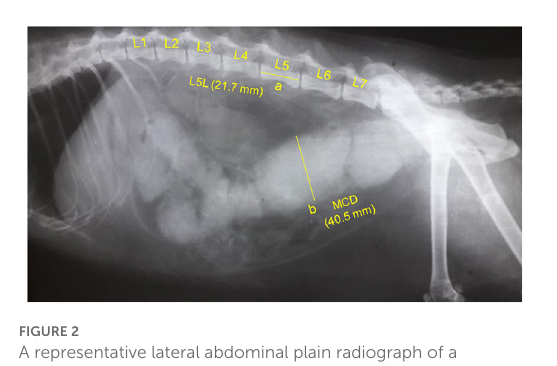
FIGURE1 A representative lateral abdominal plain radiograph of a 4.5-years-old 5.7-kg Persian intact male normal healthy cat. Measurements for the body length of the fifth lumbar vertebra (L5L, labeled a, 21.1mm), and maximum colon diameter (MCD, labeled b, 25.8mm) are displayed by solid yellow lines.